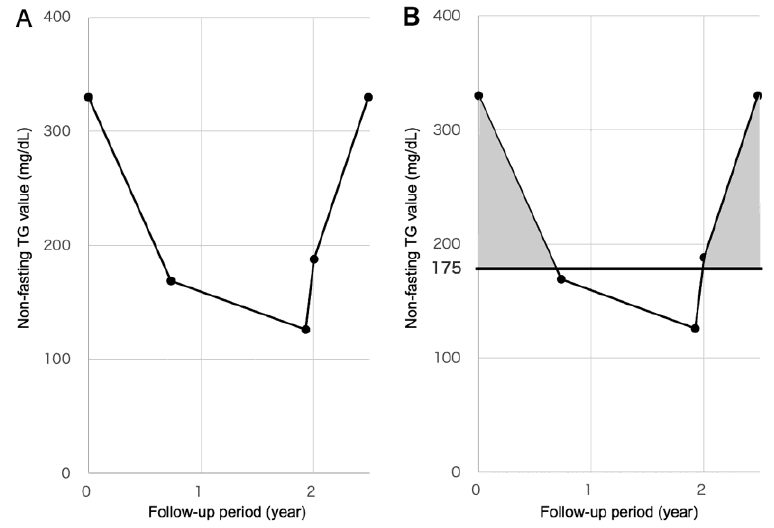
Figure 2. Calculation of the area [TG ≥ 175], which indicates cumulative non-fasting TG values ≥ 175 mg/dL during a follow-up period. ( A ) Non-fasting TG values measured during a follow-up period are shown on the line graph. ( B ) The area of non-fasting TG values ≥ 175 mg/dL during the follow-up period is calculated and the value is defined as the area [TG ≥ 175] (year-mg/dL; gray area ).